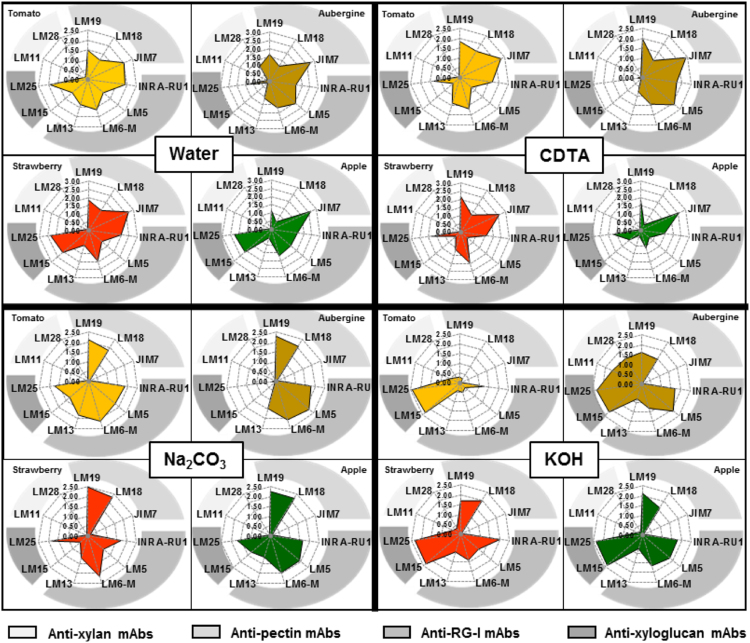
Overview of cell wall matrix polysaccharide epitope levels grouped as pectic HG, pectic RG-I, xyloglucan and heteroxylan in water, CDTA, Na2CO3, and KOH fractions from the four fruits.